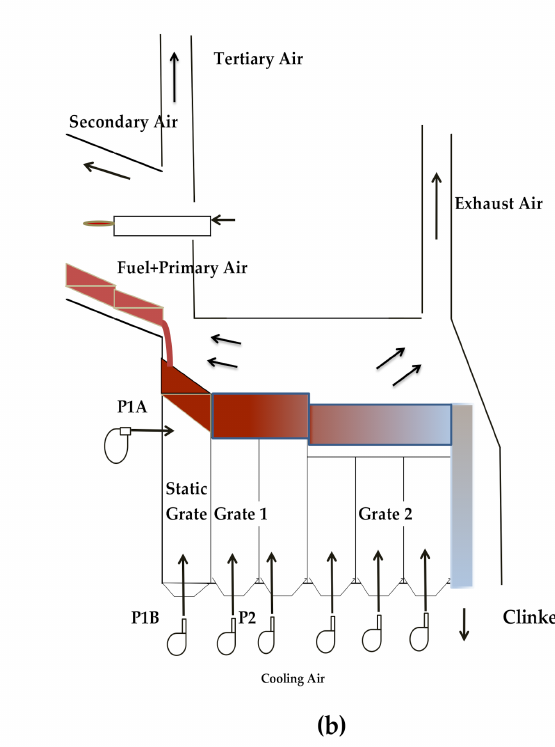
Figure 1. Simplified representation of ( a ) rotary kiln installation; ( b ) grate